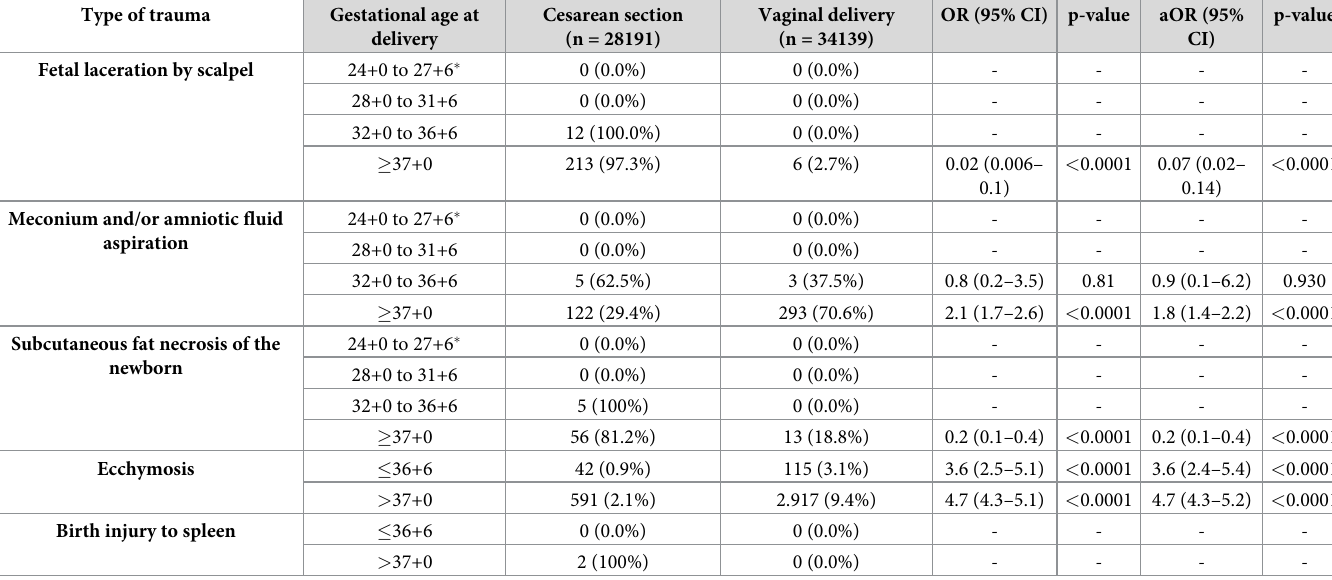
Abbreviations: OR, unadjusted odds ratio, aOR adjusted odds ratio for maternal age, parity, ethnicity, gestational age at delivery, and maternal comorbidities. “Other scalp injury” birth trauma category includes other intracranial lacerations and haemorrhages: petechiae, excoriations, scalp ecchymoses, cephalhematoma, caput succedaneum 1 Data presented as n